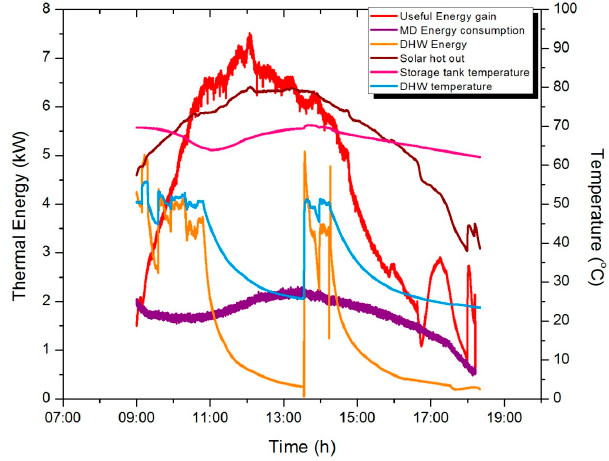
Figure 10. Typical daily operational profile of solar field and energy distribution of STSMD.